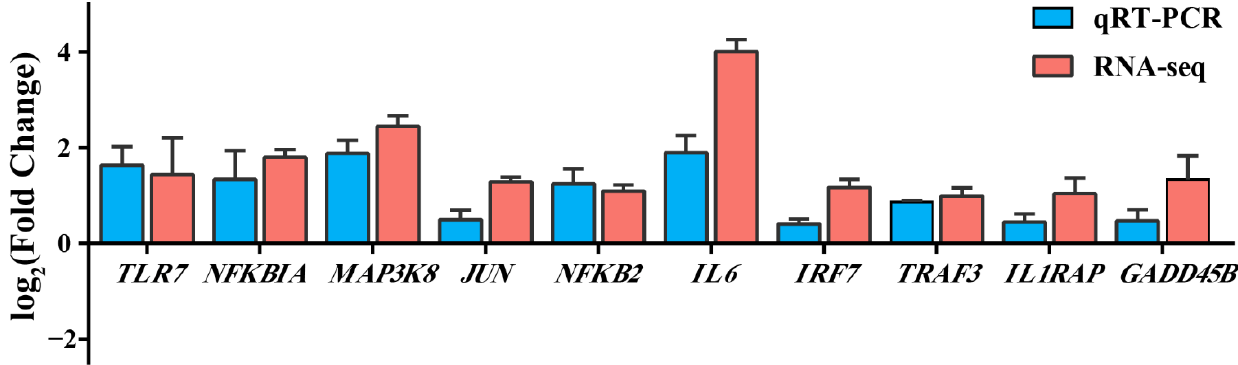
Figure 7. Validation of DEGs using qRT-PCR. The blue column represents qRT-PCR data, and the red column represents RNA-seq data.